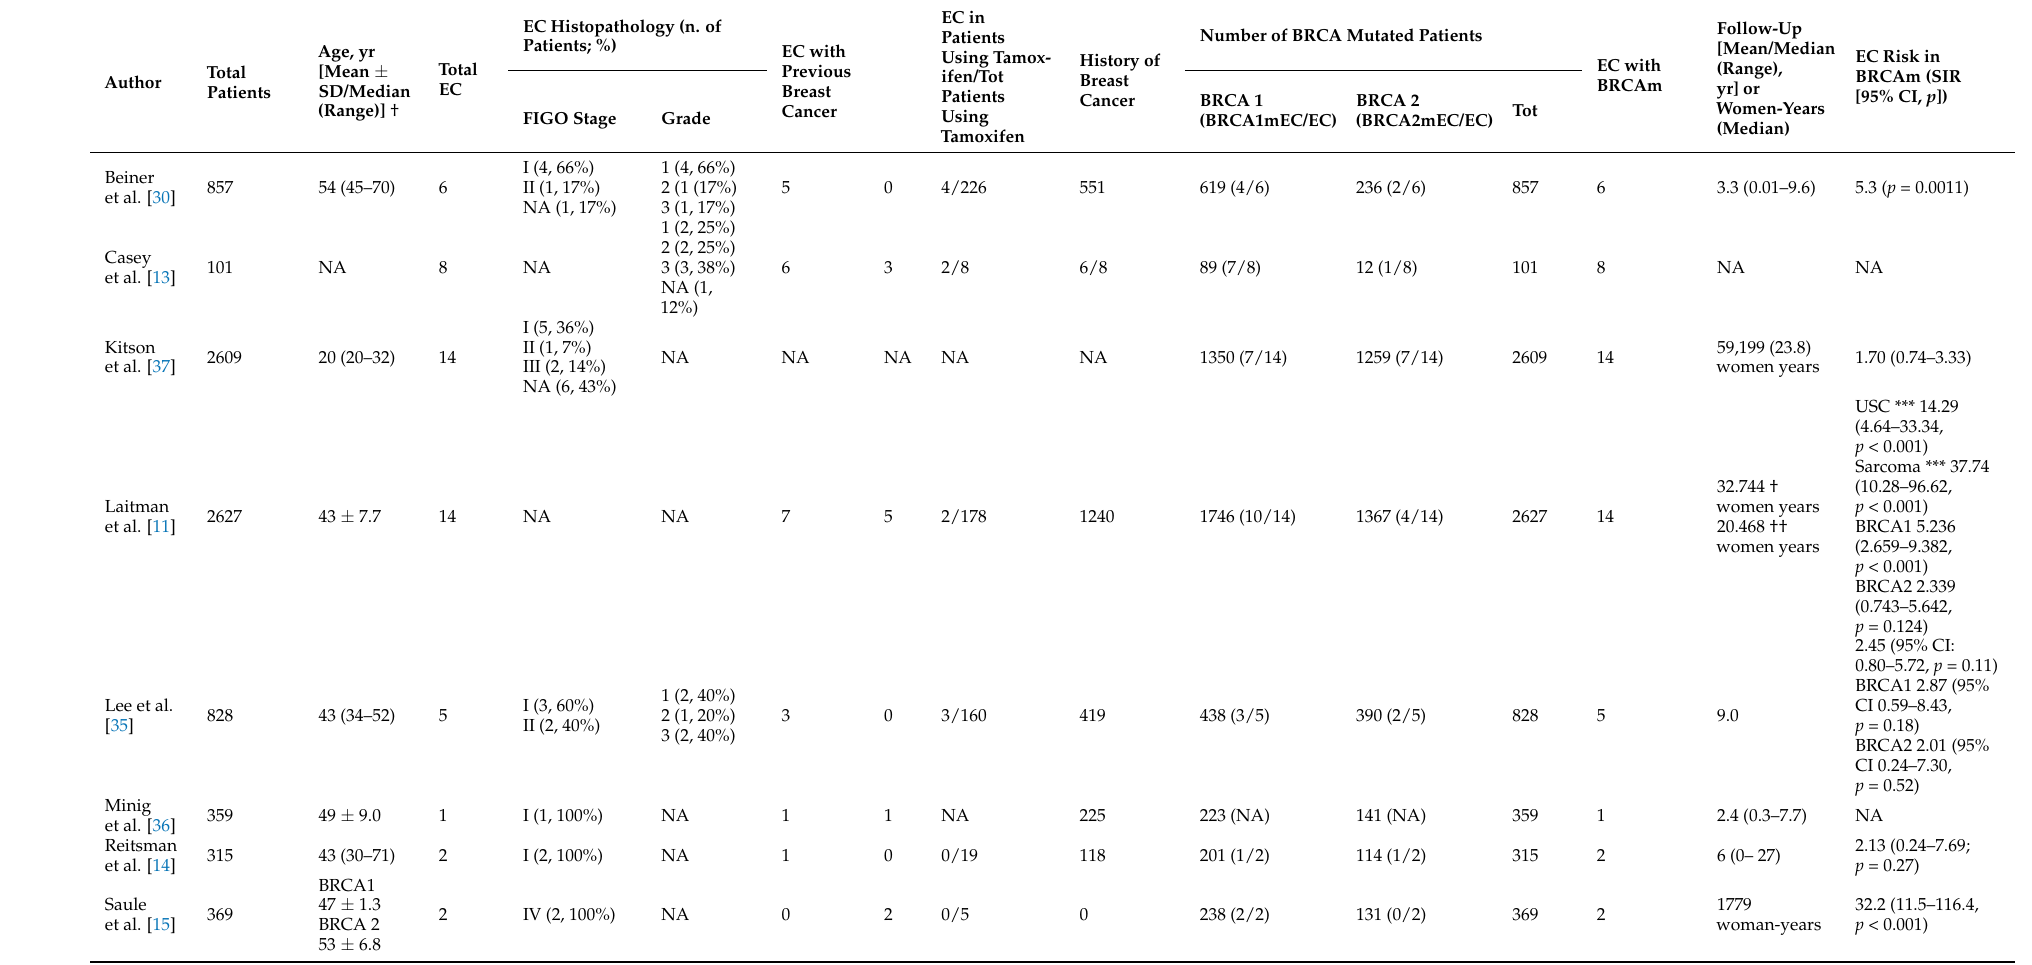
Table 5. Main findings of the included studies on the incidence of endometrial cancer in BRCAm